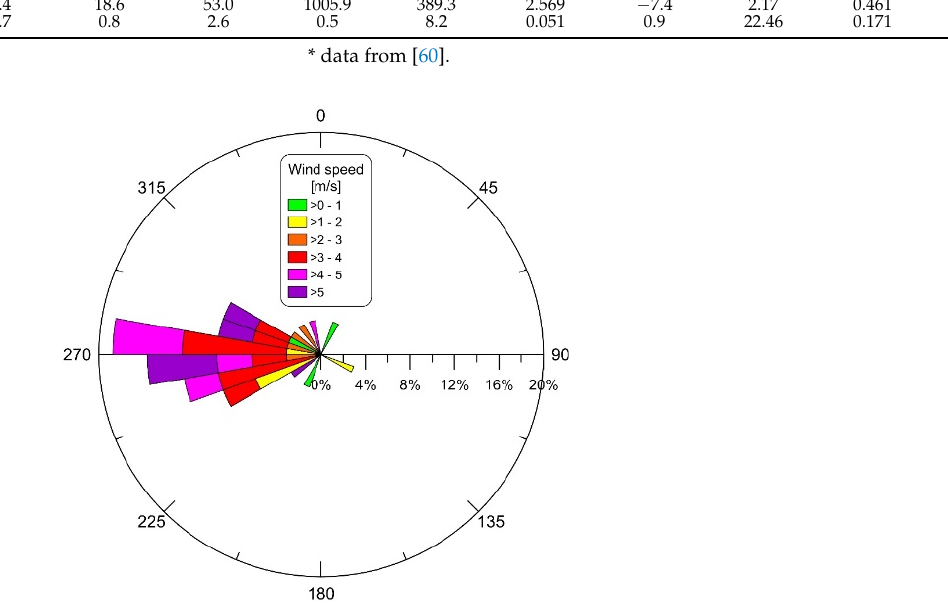
Figure 2. Wind rose measured on 22 August 2017 in the vicinity of the municipal waste landfill. Weather parameters were as follows: the air temperature varied between 17.1 and 20.2 °C (average of 18.6 ± 0.8 °C), wind speed varied between 0.0 and 6.9 m·s − 1 (average of 3.4 ± 1.7 m·s − 1 ), wind direction fluctuated between 27 and 345° (average of 258 ± 57° which indicated prevailing westerly winds Figure 2), relative humidity varied between 47.4 and 56.5% (average of 52.6 ± 2.6%) and the atmospheric pressure increased from 1004.6 to 1006.5 hPa (average of 1005.8 ± 0.5 hPa). The notably weak statistical relations (Table 3) between the different meteorological parameters due to very low parameter fluctuations are accidental rather than representative of environmental dependence. Table 2. Meteorological parameters and geochemical data of ambient air samples gathered in the vicinity of the municipal waste landfill site during the campaign on 22 August 2017.